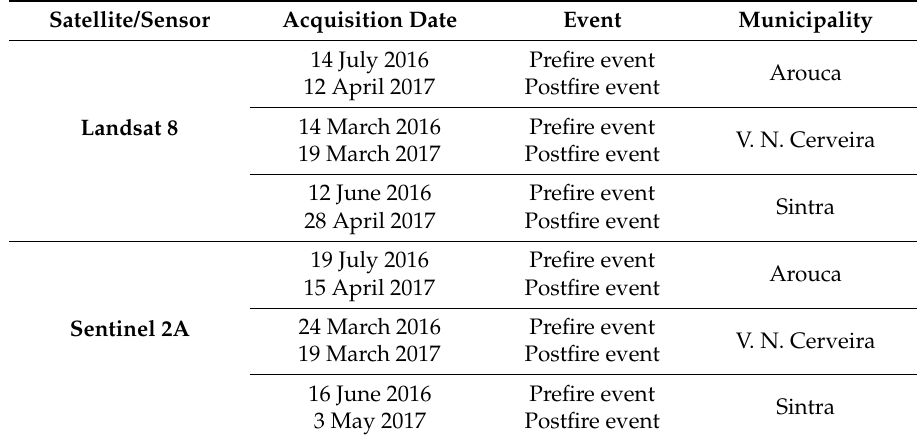
Table 2. Dataset considered in this study for the three municipalities